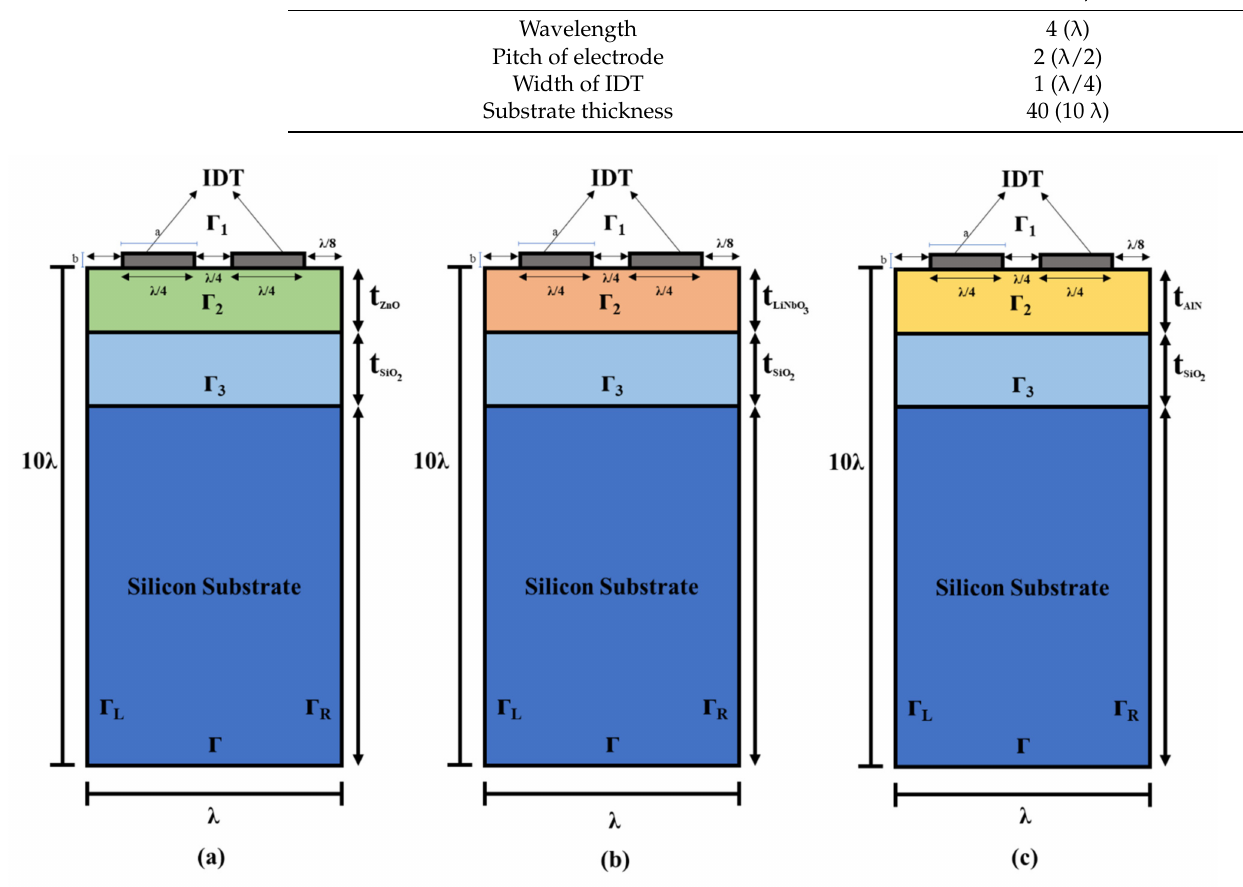
Figure 2. A two-dimensional unit cell geometry used in FEM simulation for the multilayer structure ( a ) (ZnO/SiO 2 /Si), ( b ) (LiNbO 3 /SiO 2 /Si) and ( c ) (AlN/SiO 2